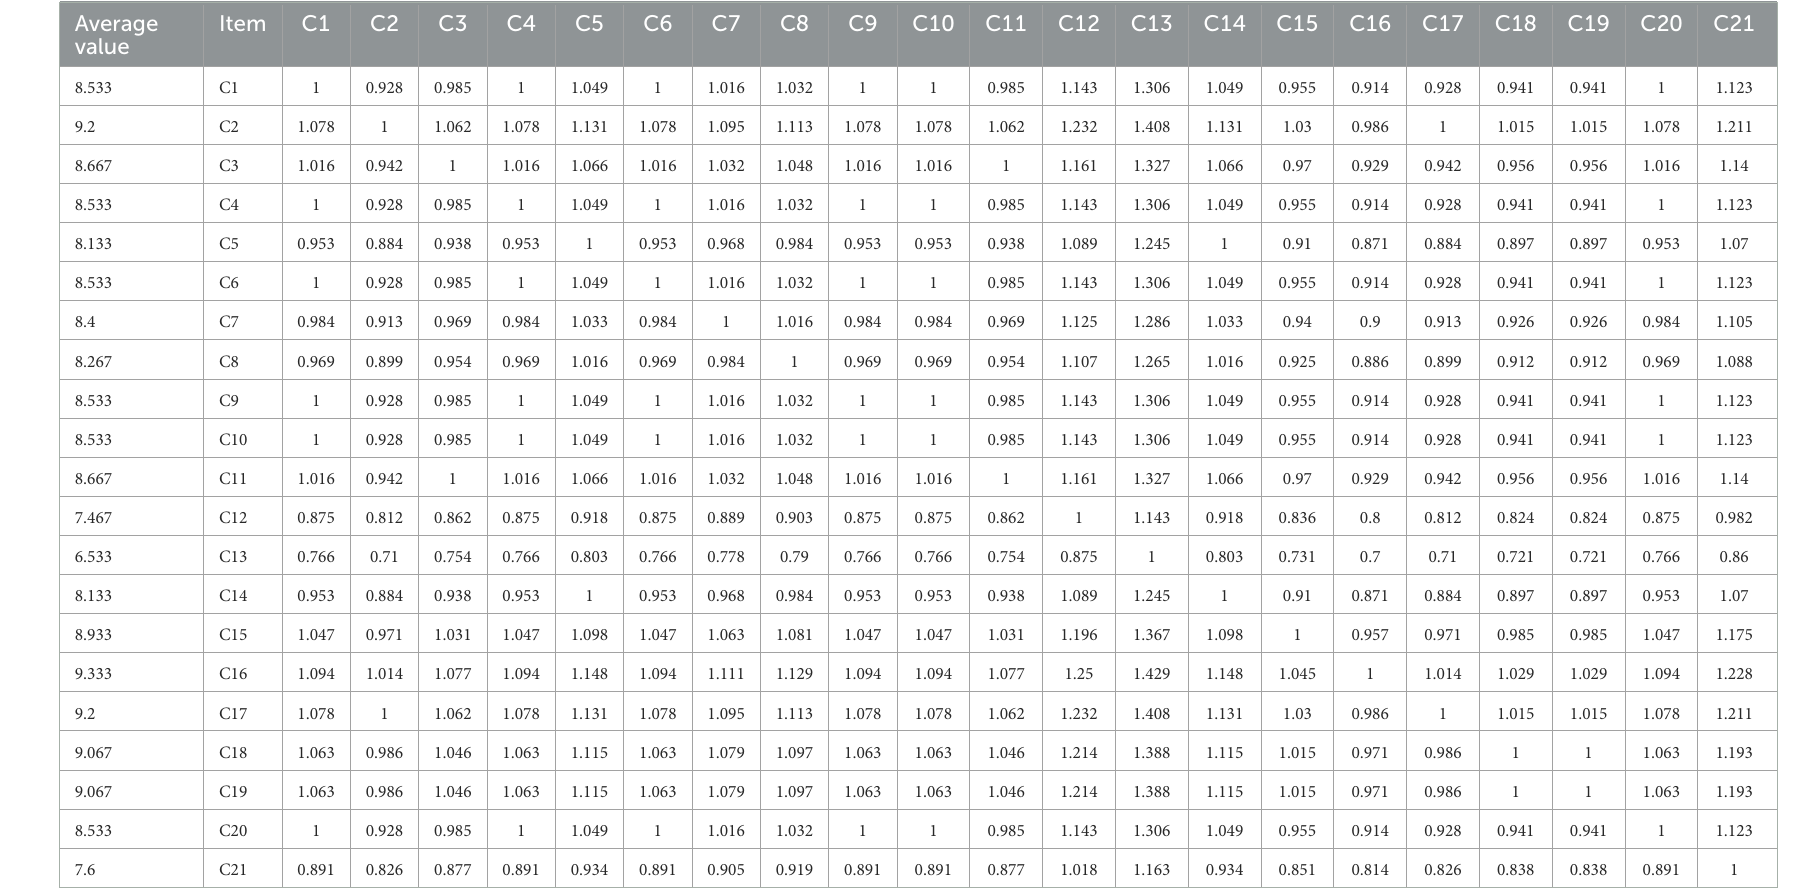
TABLE 4 AHP judgment